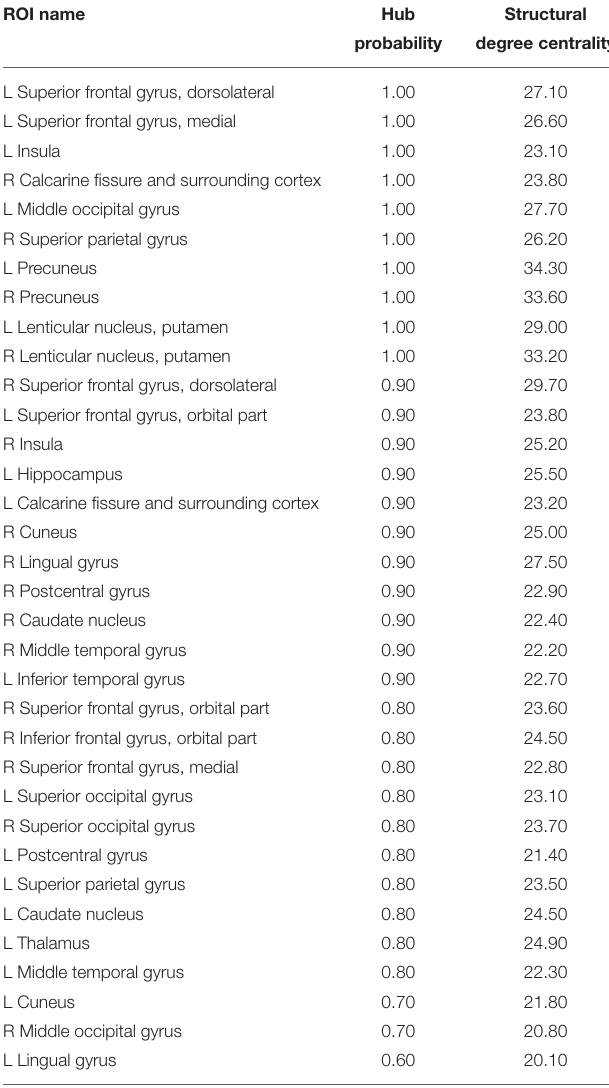
TABLE 4 | Structurally persistent brain hubs across participants